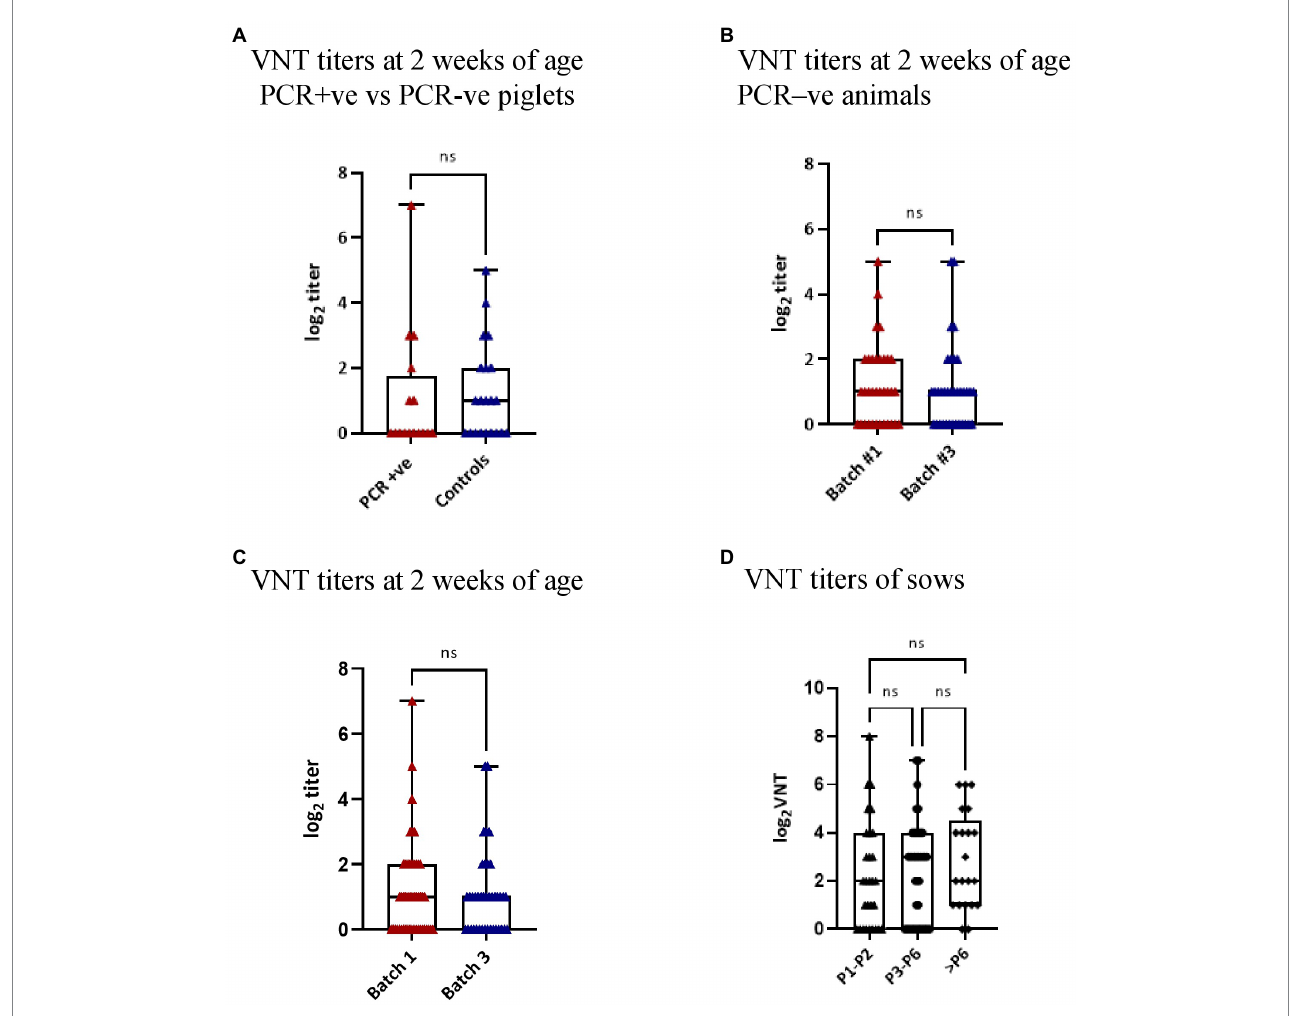
FIGURE 6 Virus neutralization titers in the different groups. Each dot represents an examined individual. Titers are shown as log 2 values and only NAb titers ≥ 2 log 2 were considered to be relevant. (A) The graph compares the VNT titers of the PCR positive (PCR + ve) animals at 2 weeks of age and their PCR negative (PCR-ve) siblings. (B) The graph shows the VNT titers of the PCR negative (PCR-ve) animals at 2 weeks of age in Batch 1 and 3. (C) The graph shows the VNT titers of 2-week-old piglets of Batch 1 and 3. (D) The graph shows the VNT titers according to the parity of the 96 sows sampled one year after the onset of the outbreak. ns = not